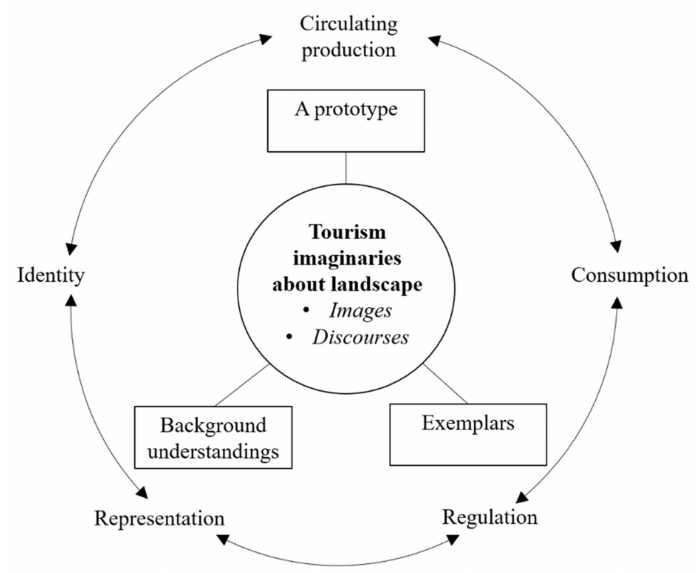
Figure 1. A conceptual framework for tourism imaginaries about landscape.